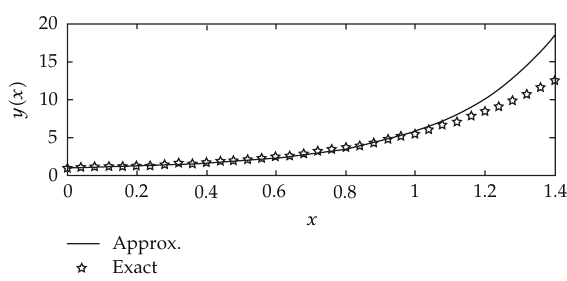
Figure 5: The graph indicates the solution y (cid:3) x (cid:4) for (cid:3) 4.21 (cid:4) , when α (cid:7)